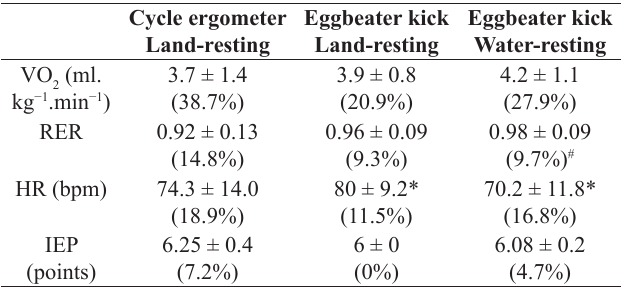
Table 2. Means, standard deviation, and coefficients variation of oxy- gen uptake (VO ), respiratory exchange ratio (RER), heart rate (HR), 2 the perceived exertion index (IEP) in resting in pre-cycle ergometer test, and pre-eggbeater kick test (land and water); n =